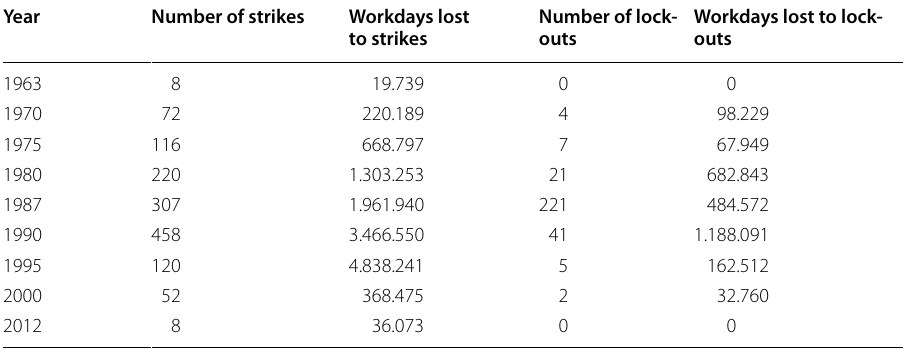
Table 6 Strikes and lock-outs in Turkey. Source : Data were derived from Ministry of Labour and Social Security (in Turkish, grev ve lokavt